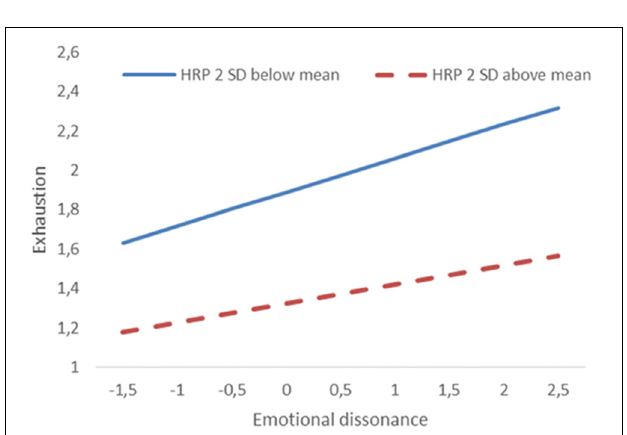
FIGURE 2 | Moderator effect of human resource primacy (HRP) on the relationship between emotional dissonance and exhaustion. HRP and emotional dissonance are mean centered. Both slopes are significant ( p <